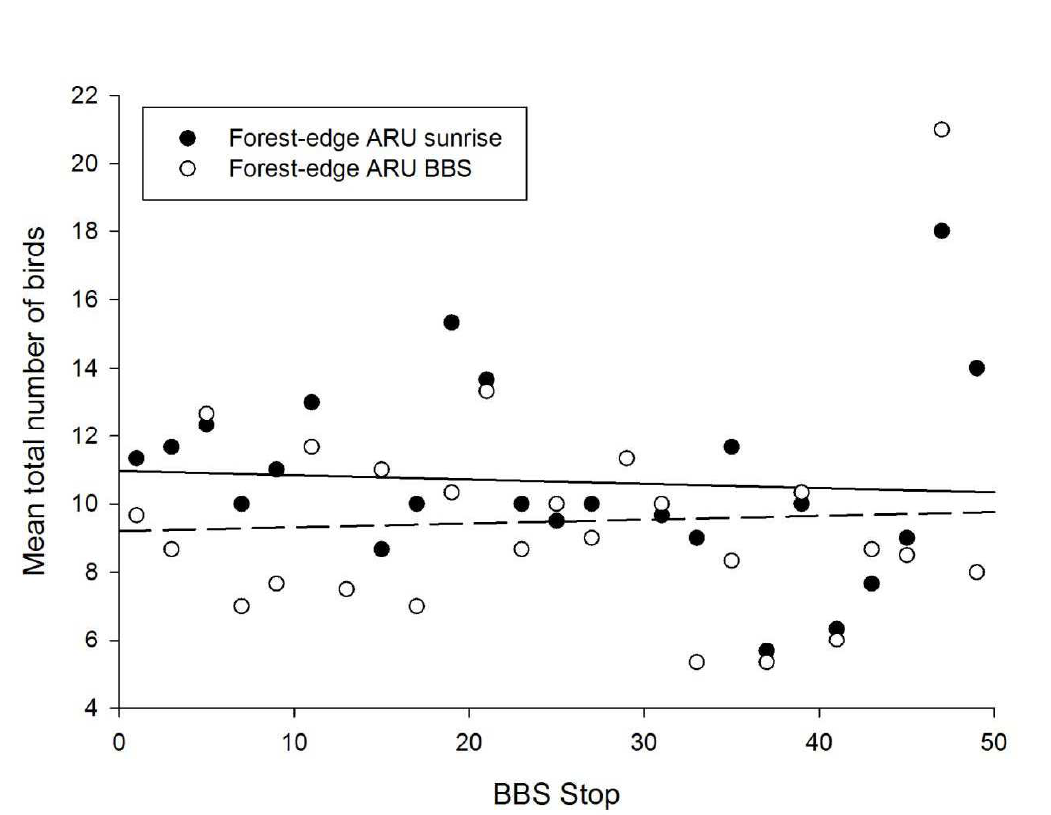
Figure A3.2. Mean total number of birds detected at each BBS stop from forest-edge ARU- based surveys conducted in 2015 during traditional BBS time and sunrise on three routes conducted in the Northwest Territories, Canada. Solid and broken lines indicate Forest-edge ARU Sunrise and Forest-edge ARU BBS,